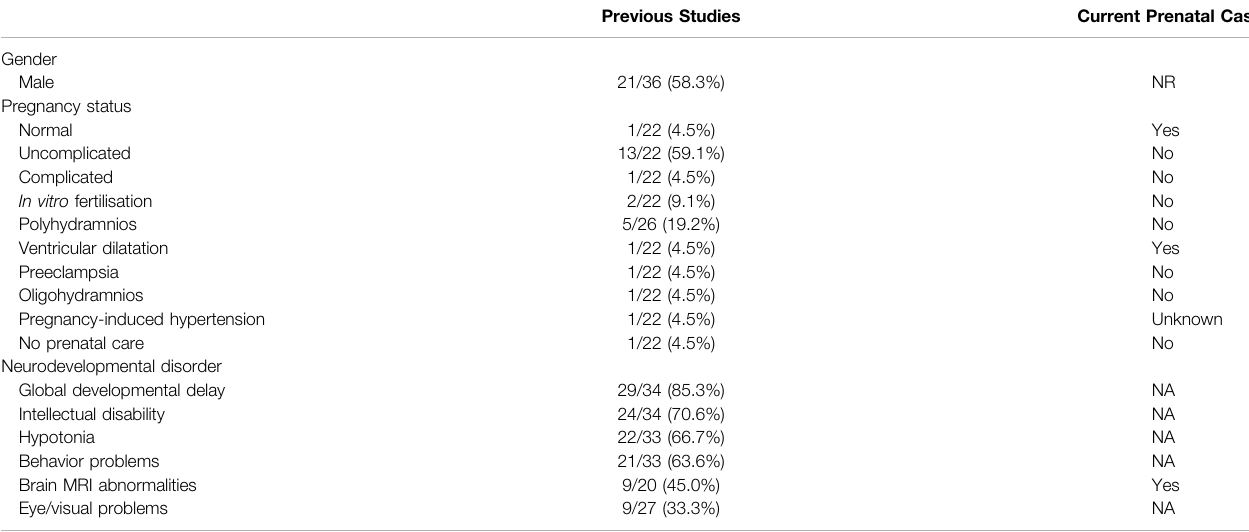
TABLE 2 | Clinical features of patients with TAOK1 variants.